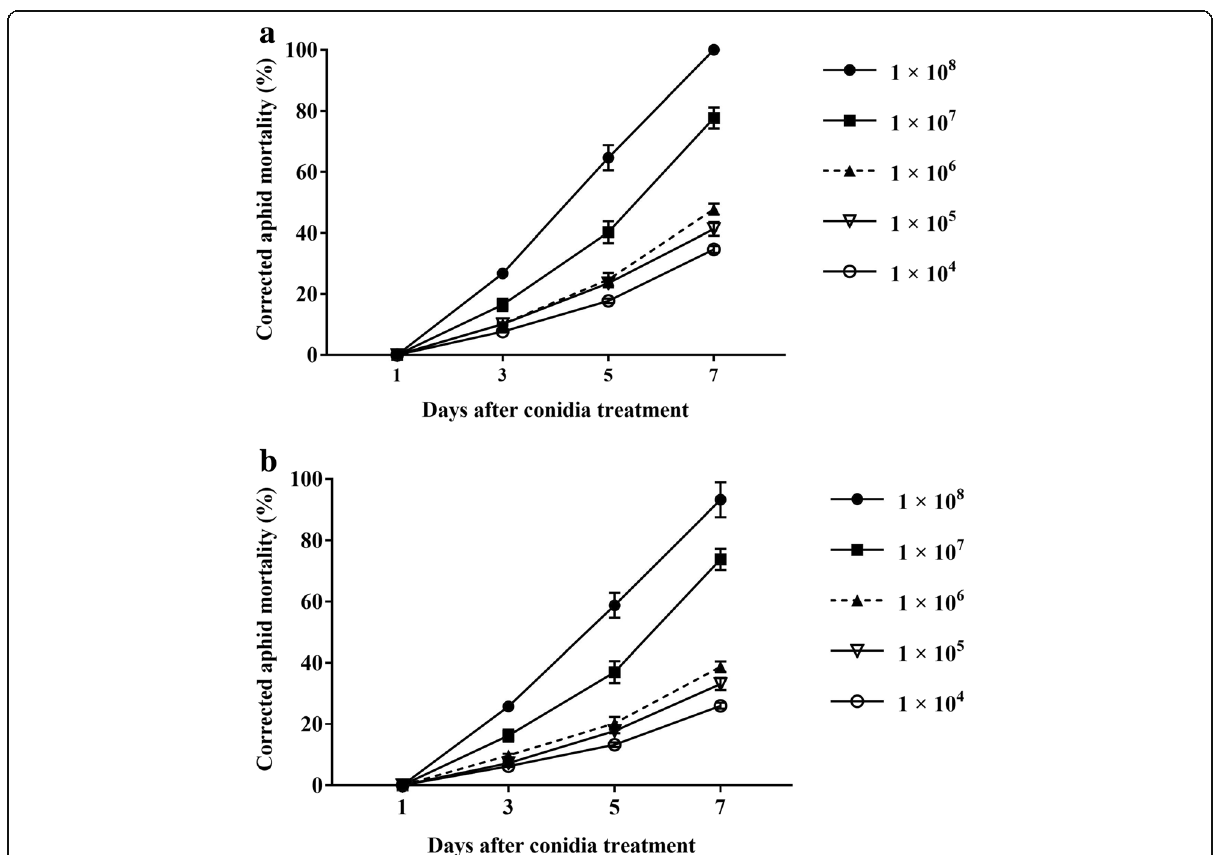
Fig. 2 The effect of conidial concentration of L . lecanii isolate and days after fungal application on the cumulative mortalities (±SE) of a M . persicae and b A.